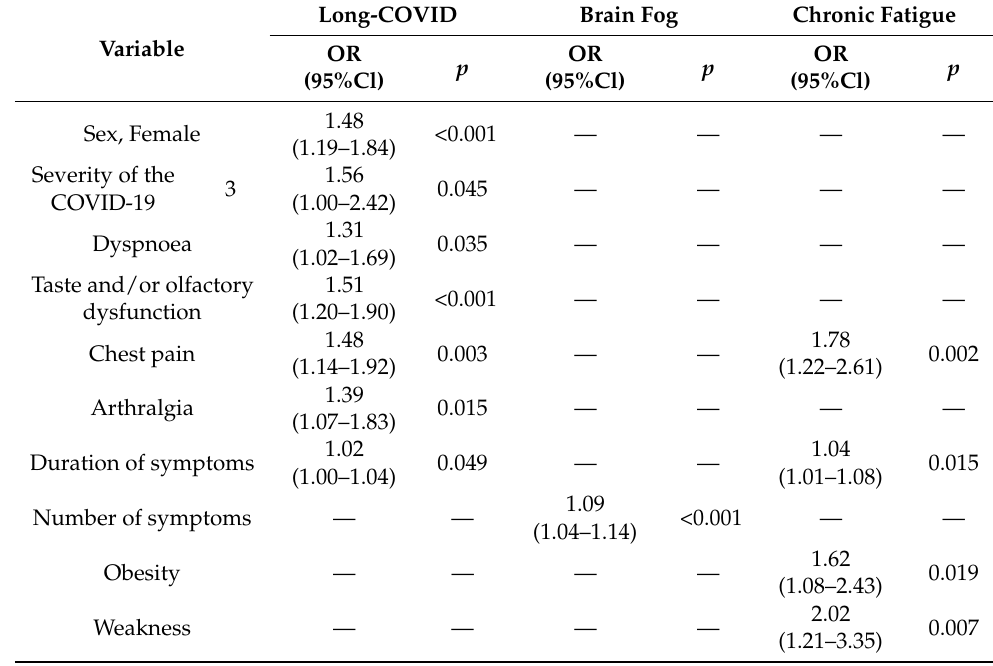
Table 4. Multivariate analysis based on a model incorporating statistically significant predictors from univariate analysis on the risk of developing long-COVID syndrome, brain fog, and chronic fatigue.